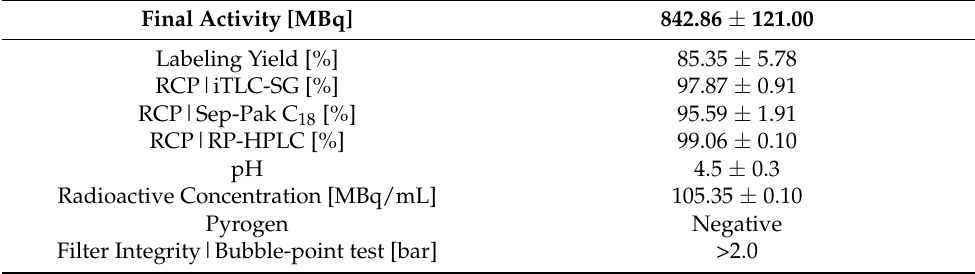
Filter Integrity|Bubble-point test [bar] >2.0 Values are expressed as “mean ± SD” ( n =